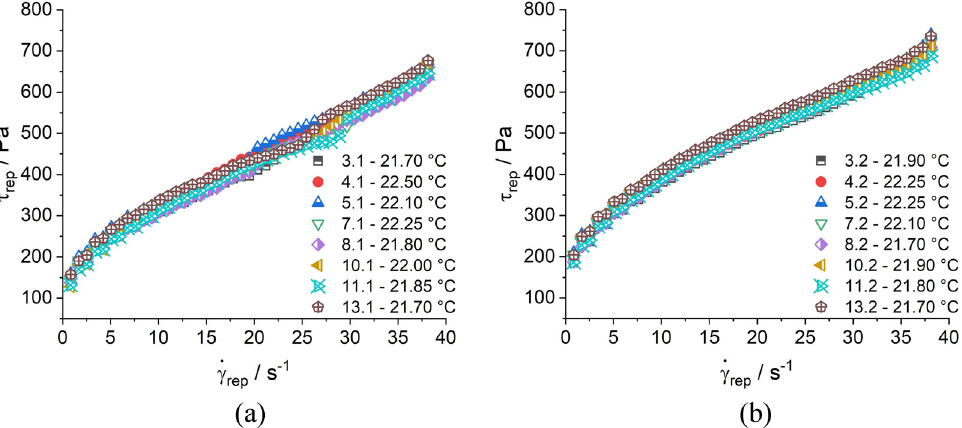
Figure 12: Selected representative values of the adjusted concrete mix of the fi rst individual measurements ( a ) and the second individual measurements ( b )